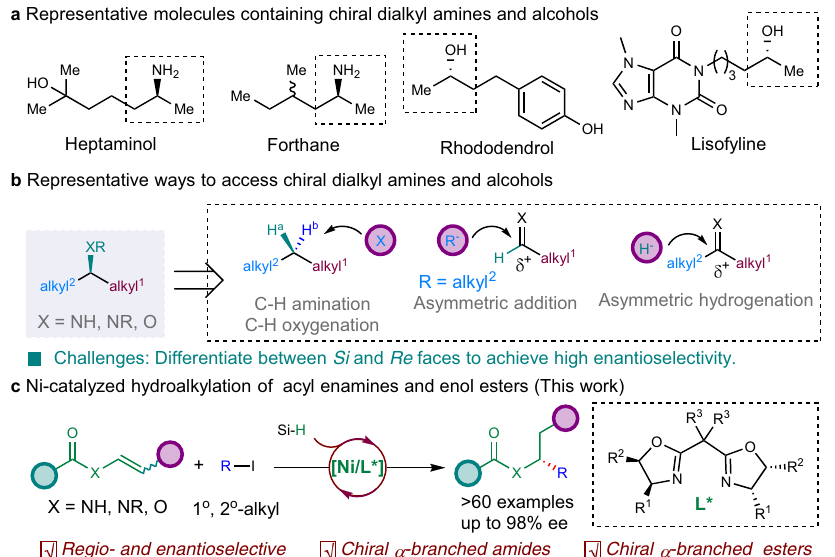
Fig. 1 Impetus for the development of the reaction. a Representative molecules containing chiral secondary alkyl-substituted amines and alcohols. b Representative ways to access chiral secondary alkyl-substituted amines and alcohols. c Ni-catalyzed hydroalkylation of acyl enamines and enol